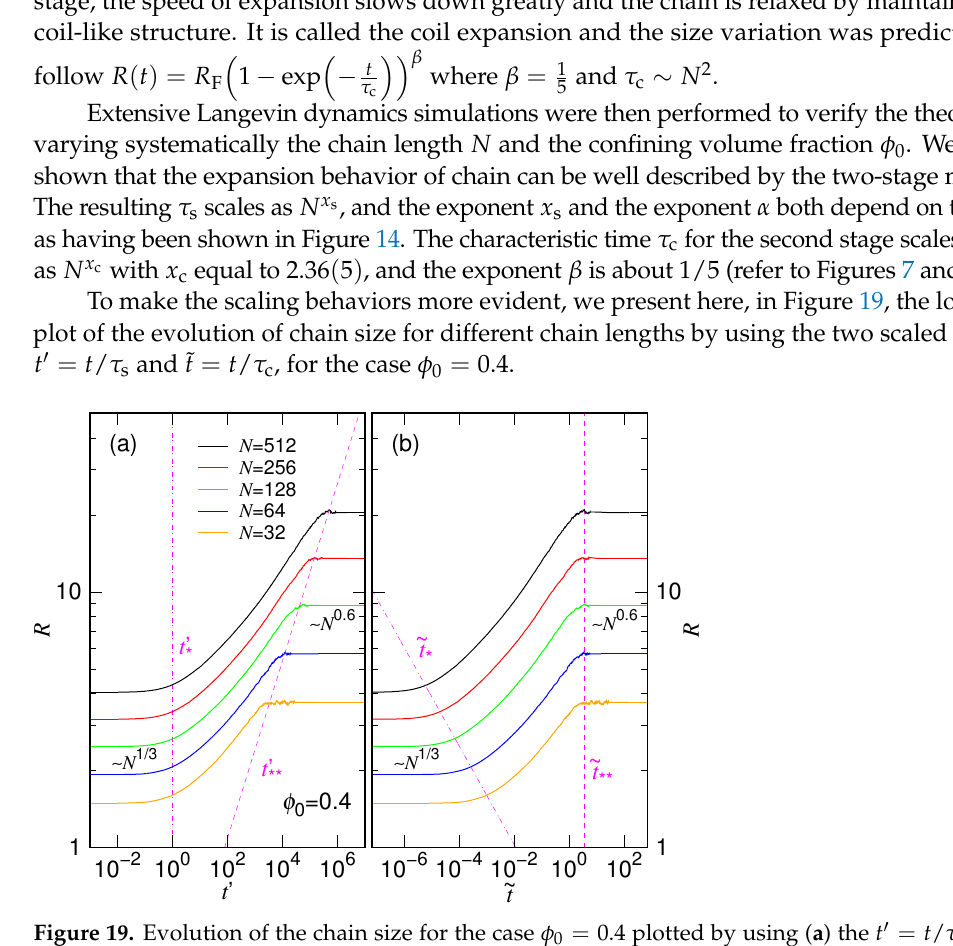
Figure 19. Evolution of the chain size for the case φ 0 = 0.4 plotted by using ( a ) the t (cid:48) = t / τ s time scale and ( b ) the ˜ t = t / τ c time scale. The chain length can be read in the legend of Panel ( a ). The lines demarcating the regimes for the sphere-like state and the final coil state are plotted in dash-dotted and dashed lines, respectively, both in magenta